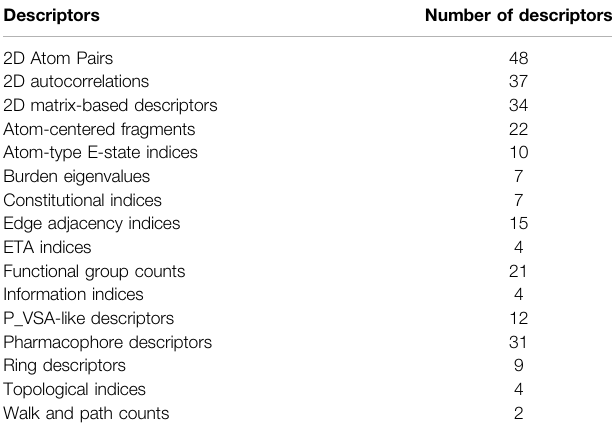
TABLE 1 | Number of the molecular descriptors using model